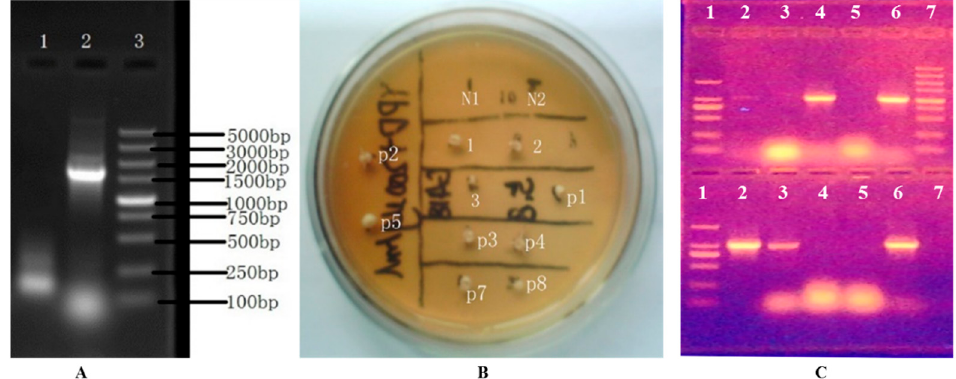
Figure 2. The selection and verification of the deletion cassette of BAT2 gene and true BAT2 gene mutants. ( A ) The verification of the constructed BAT2 gene-deletion cassette. Therein, Lane 1: negative control; Lane 2: BAT2 gene-deletion cassette; Lane 3: DL 5000 DNA marker. ( B ) The secondary plate selection of the potential transformants using 200 μ g/mL of G418. Therein, N1 and N2: negative controls (untransformed colonies); 1, 2, 3, p1, p2, p3, p4, p5, p7, and p8: the 10 potential transformants with G418 resistance. ( C ) The verification of true BAT2 gene-deletion mutants with PCR and electrophoresis. Therein, upper panel: Lane 1: DL2000 DNA marker (bands from top to bottom are in the order of 2000 bp, 1000 bp, 750 bp, 500 bp, 250 bp, and 100 bp); Lane 2: negative control of PCR; Lanes 3, 4, 5, and 6: the PCR product bands of BAT2 gene of transformants p1, p3, p4, and p7, respectively; Lane 7: DL5000 DNA marker; lower panel: Lane 1: DL2000 DNA marker; Lane 2: the PCR product of BAT2 gene of the parental S. cerevisiae 38; Lanes 3, 4, 5, and 6: the PCR product bands of BAT2 gene of transformants 1, 2, 3, and p8, respectively.